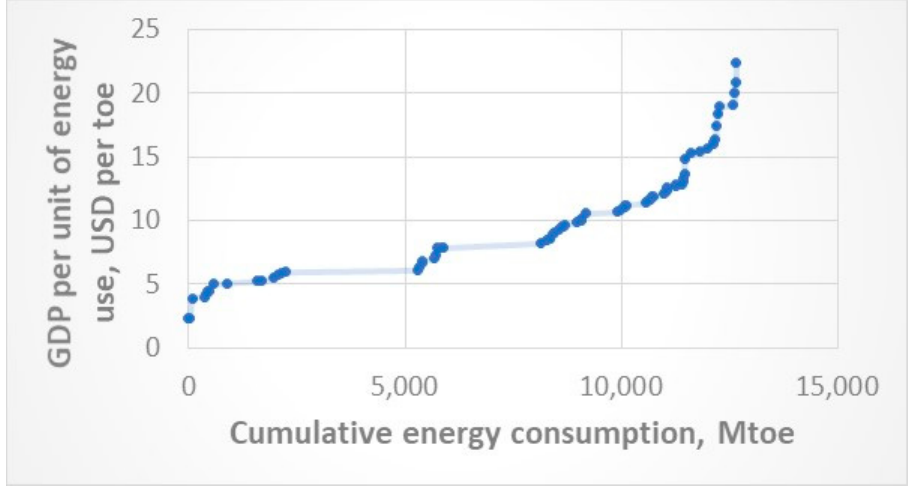
Figure 4. Cumulative curve of the energy density of GDP and energy consumption in 74 national economies (2016). Source: calculated by the authors based on [58]. economies (2016). Source: calculated by the authors based on